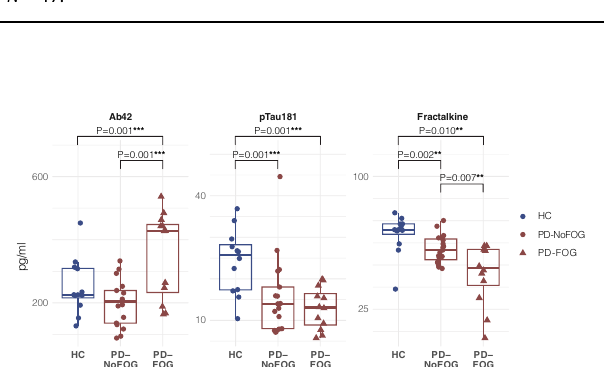
Fig. 1 CSF biomarker levels. Box plots depicting expression of the CSF markers A β 42, p-Tau 181 , and Fractalkine across study groups. Boxes and horizontal lines depict ranges Q1 – Q3 and median values of the expression of each marker, respectively. HC healthy control, PD-NoFOG PD without FOG, PD-FOG PD with FOG. P values re fl ect multivariate linear models controlled for sex, PD duration, and false discovery rate. ** P ≤ 0.01, Wald tests. †† P = 0.007, post hoc F -test between PD-NoFOG and PD-FOG controlling for sex and